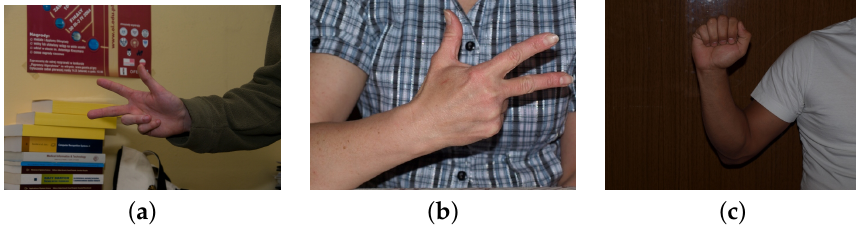
Figure 1. Samples of images from the dataset HGR (Hand Gesture Recognition) [36].